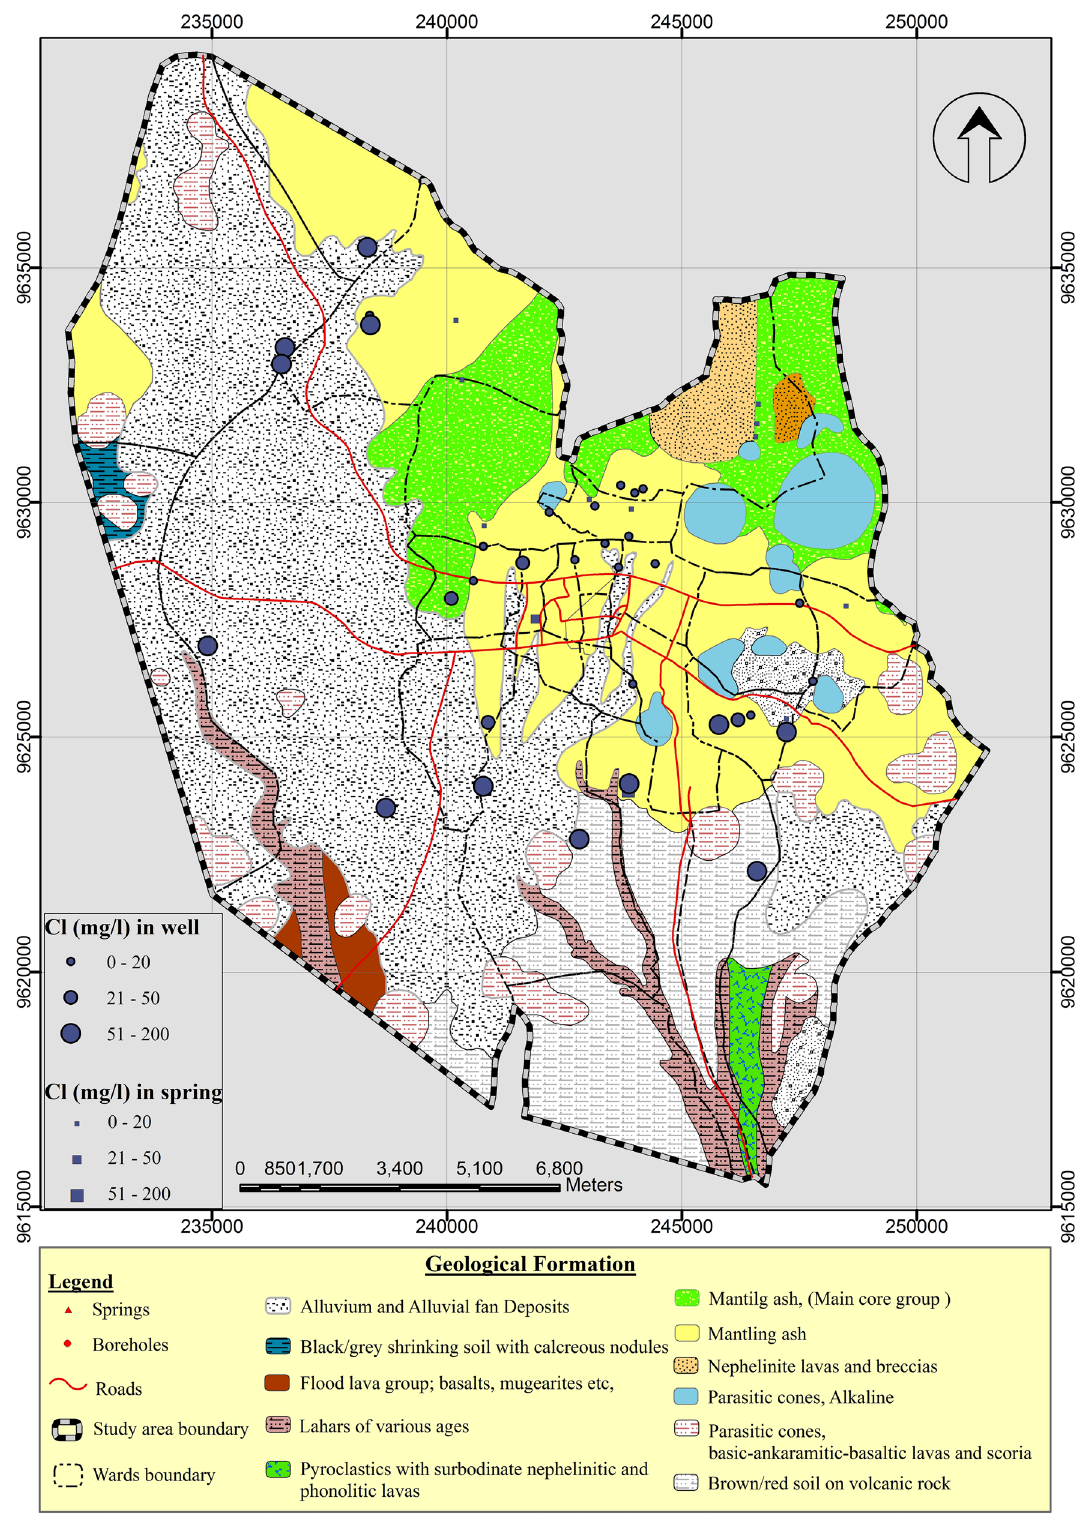
Fig. 13 Chloride distribution map for spring and well